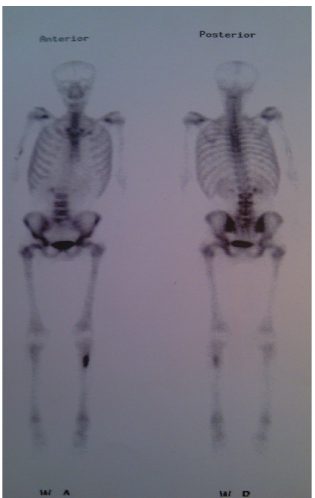
3(b)). Chest X-ray of patient was normal (Figure 4).